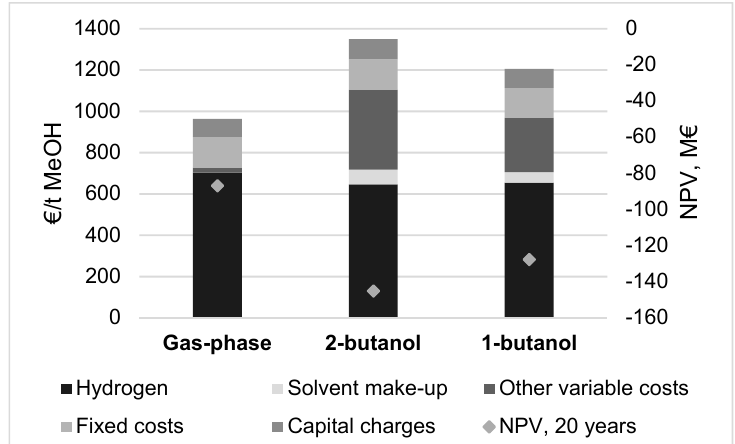
Figure 5. Methanol production cost and net present value (NPV) of the different CO 2 hydrogenation processes. Capital costs are annualized at an interest rate of 5% to obtain the annual capital charges. NPV is calculated assuming plant lifetime of 20 years and discount rate of 8%. Other variable costs: carbon dioxide, by-products and waste, and utilities.